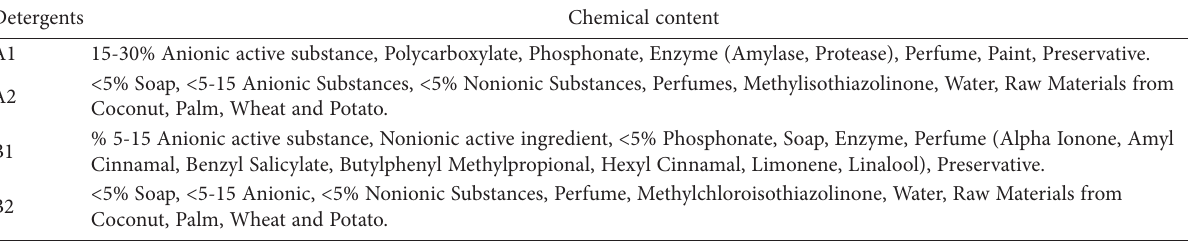
Table 1. The chemical contents of the four detergents A1, A2, B1 and B2. Detergents Chemical content